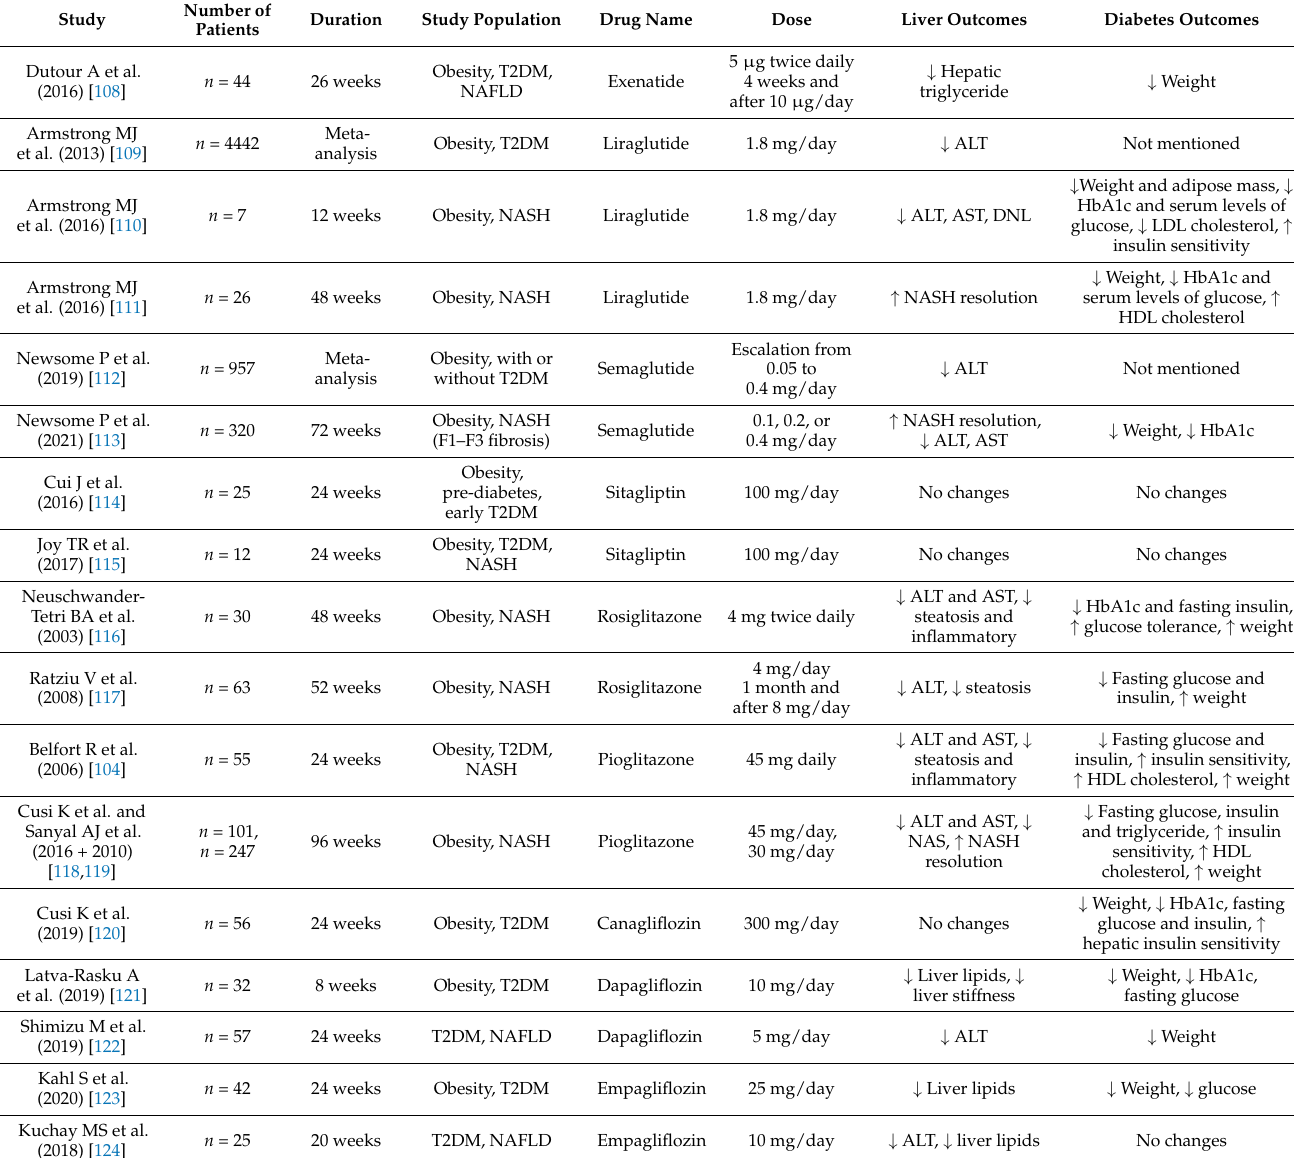
Table 4. Beneficial effects of anti-diabetic drugs on